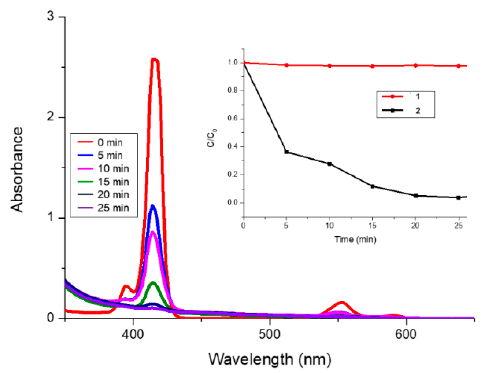
Figure 2. UV-vis absorption spectra of SnP 6+ remaining after the equilibrated adsorption on Nafion- coated Pt-TiO 2 ( 2 ). The inset depicts the comparison of absorption changes in Soret bands of SnP 6+ according to adsorption progress with time on 1 and 2